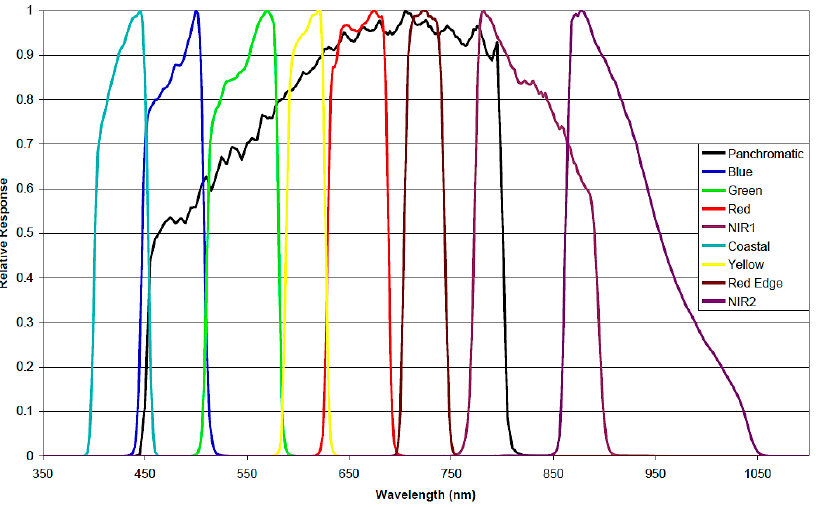
Figure 3. Worldview-2 relative spectral radiance response (nm) [32].